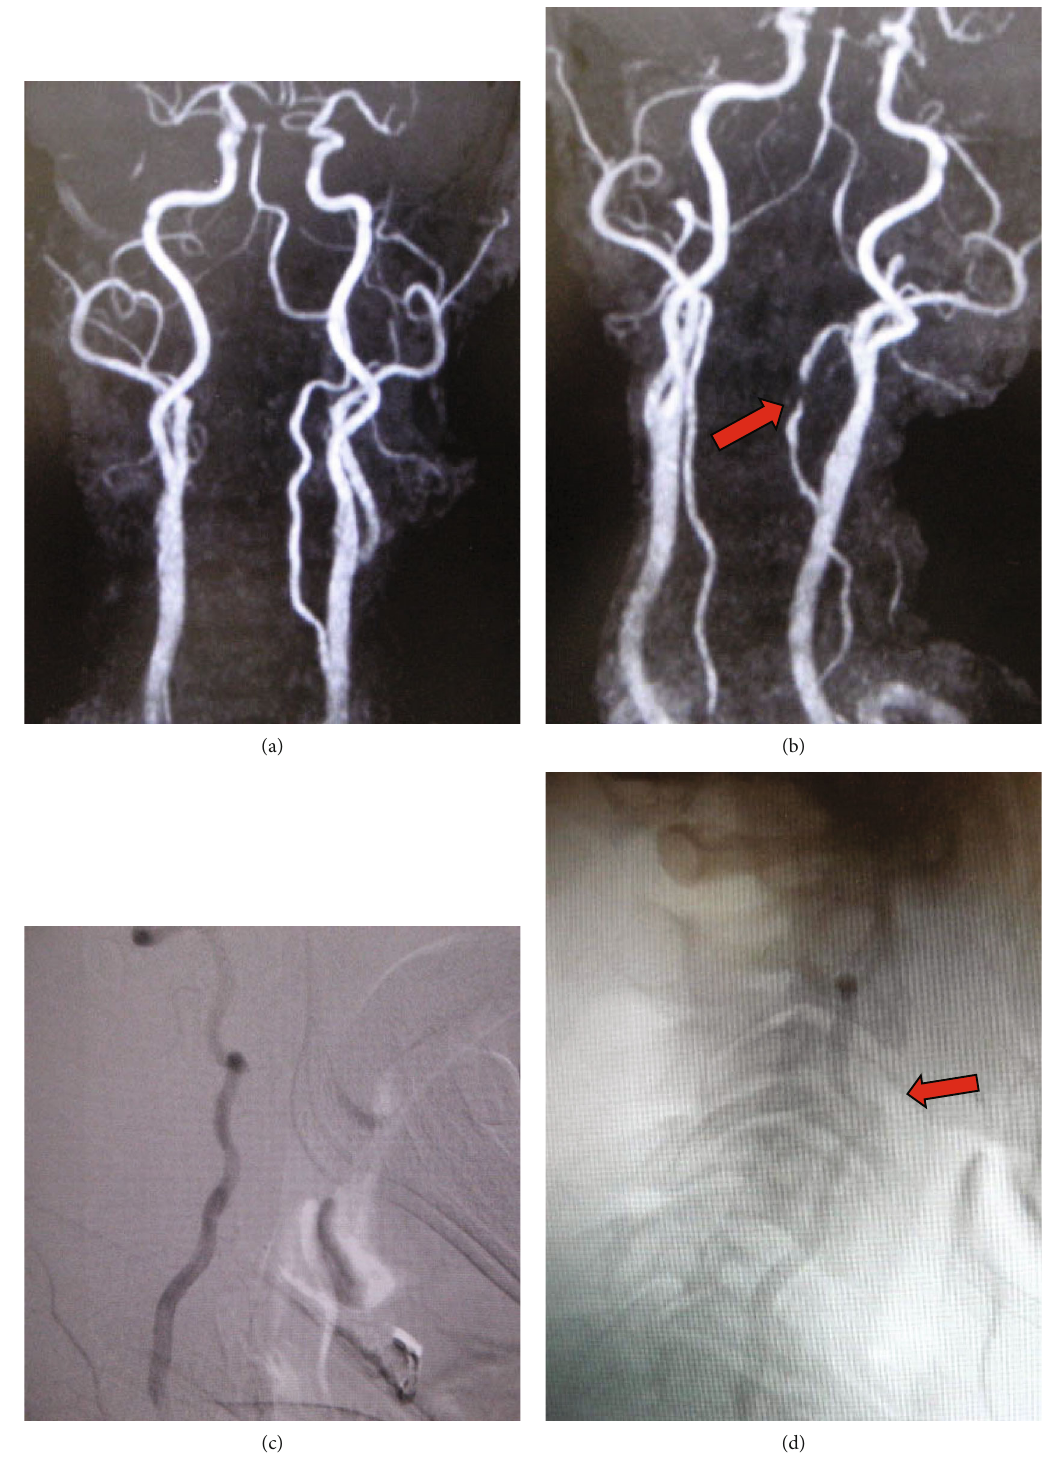
Figure 1: Preoperative MRA shows normal fl ow and left VA dominant in the neutral position (a). MRA with neck rotation of 45 degrees revealed severe stenosis (arrow) of left VA (b). Preoperative cerebral angiograms of left VA show (c) normal fl ow in the neutral position and (d) severe stenosis at C3-4 level (arrow) and decreased fl ow on leftward neck